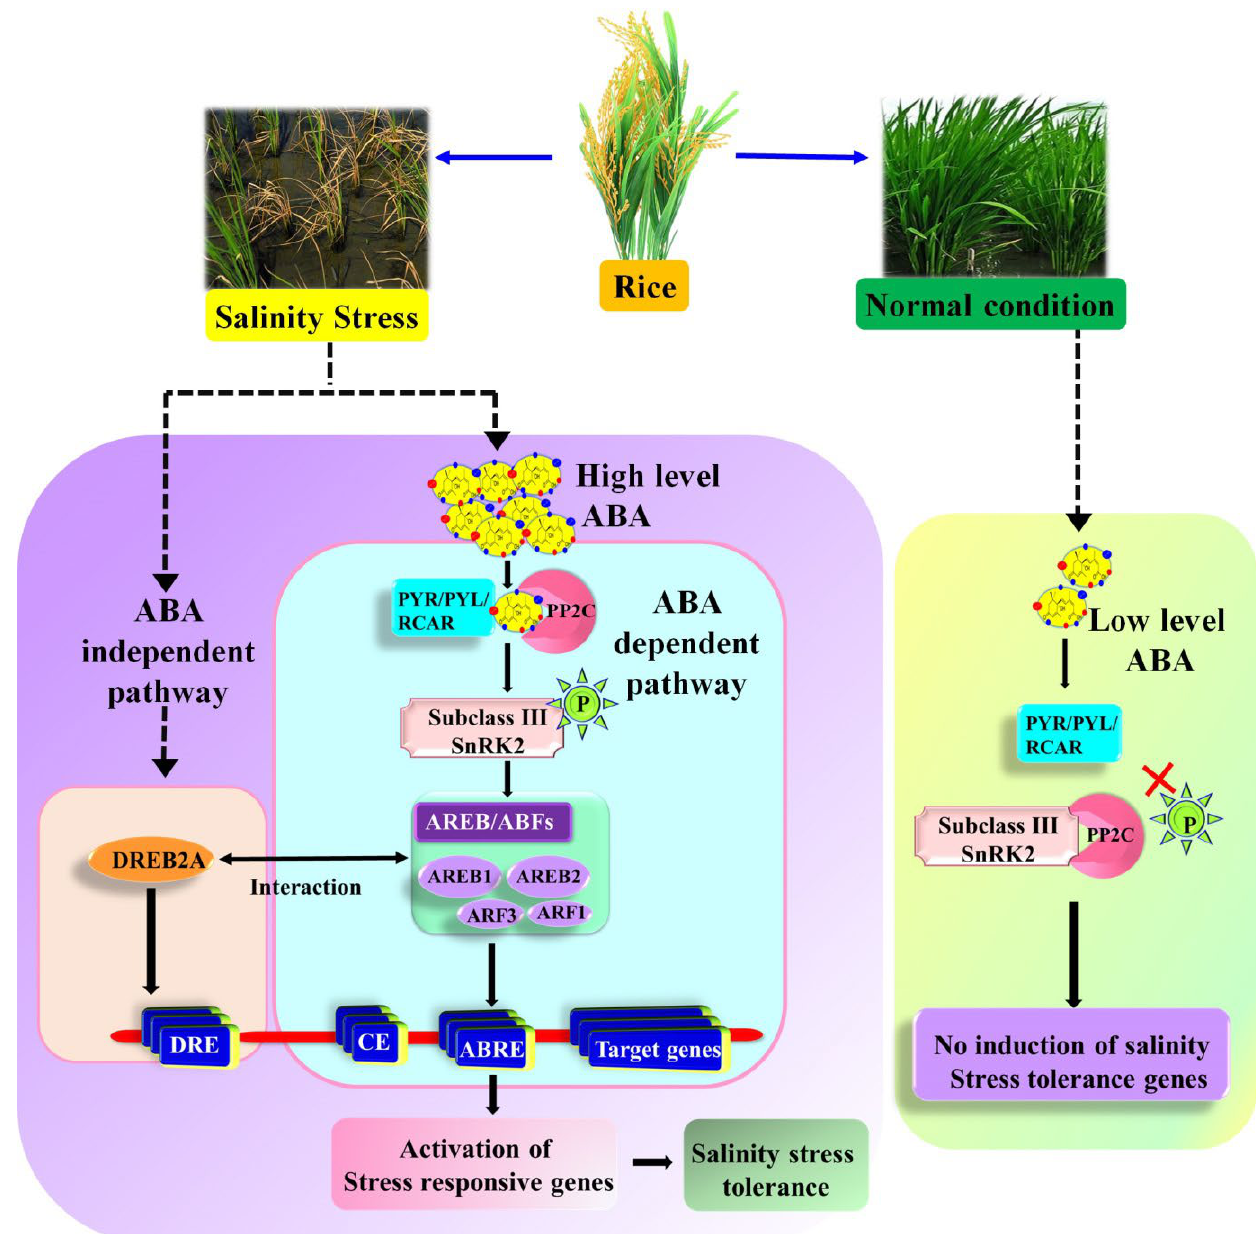
Figure 3. ABA-dependent and -independent pathway in rice under normal and salinity stress conditions. ABA-dependent pathway includes regulatory components (PYR/PYL/RCAR), PP2C, subclass III SnRK2, and four ARBB/ABF transcription factors such as AREB1, AREB2, ARF3, and ARF1 gene expression. ABA-independent pathway includes transcription factors (DREB2A) and stress-related genes. CE—coupling element.